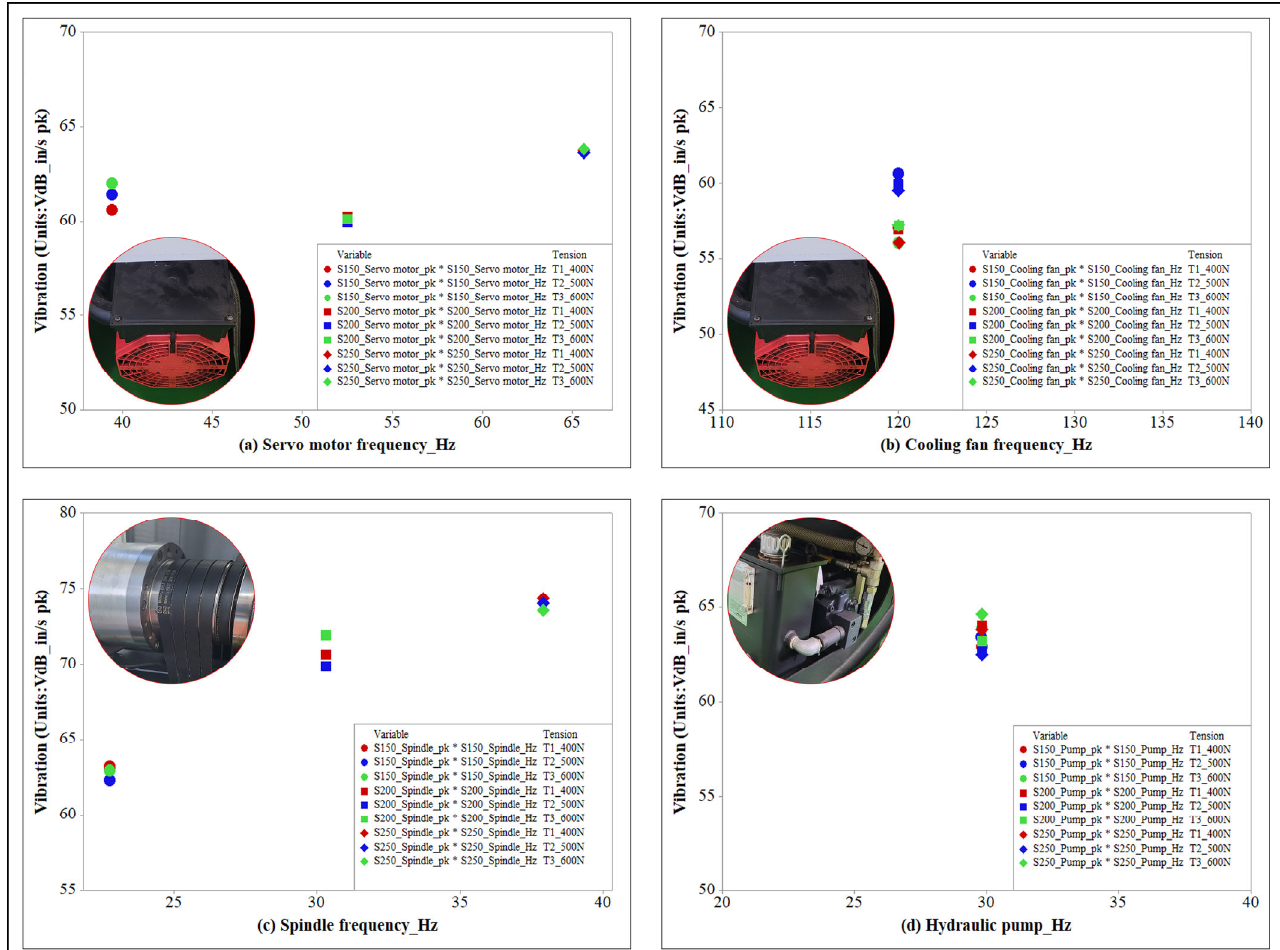
Figure 5. Results of frequency analysis of measured vibrations. ( a ) Frequency analysis of servomotor; ( b ) frequency analysis of cooling fans; ( c ) frequency analysis of spindle; and ( d ) frequency analysis of hydraulic pump.